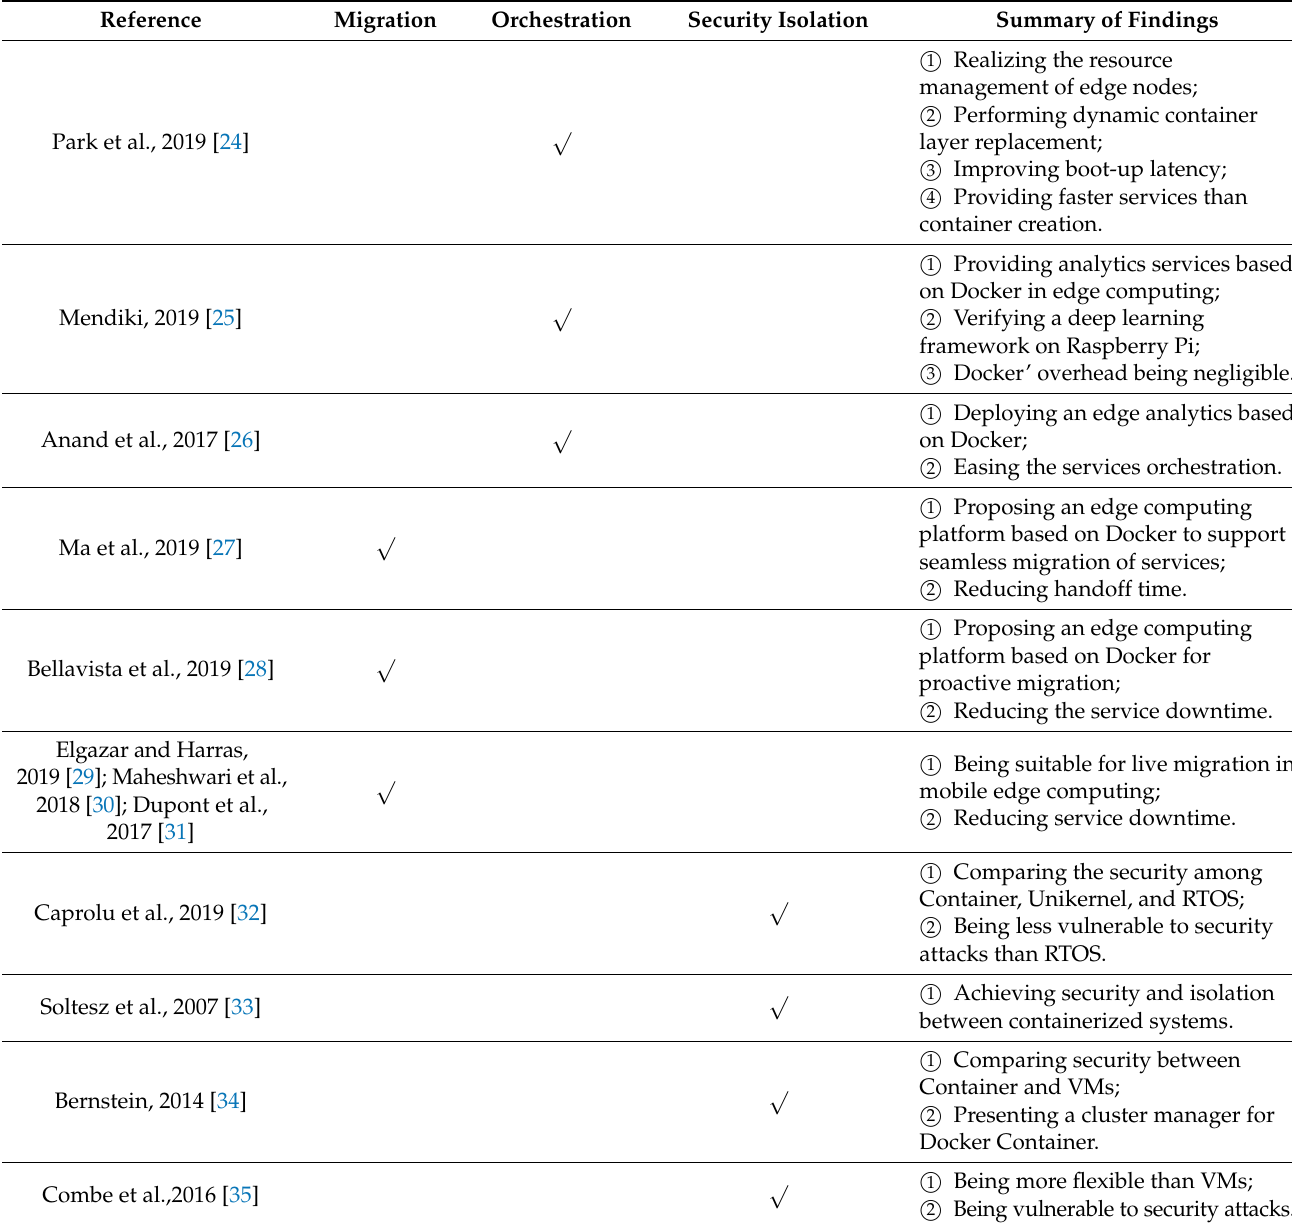
Table 1. Studies of Container for different